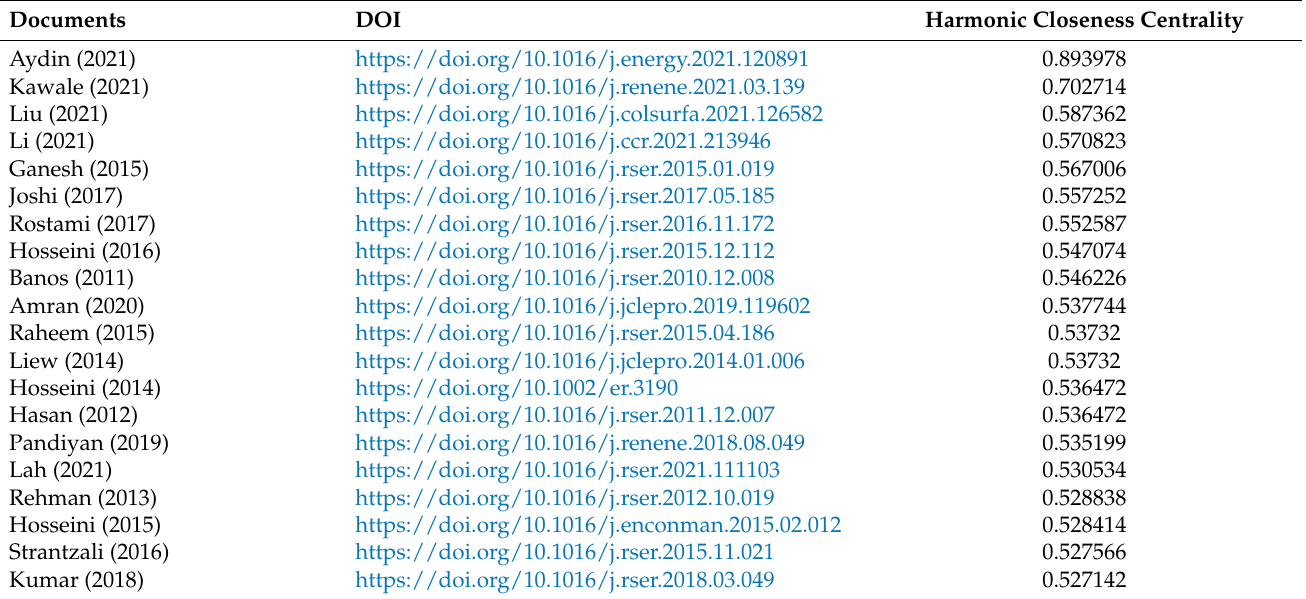
Table 6. Top-20 documents with higher harmonic closeness centrality from WoS database for biblio- graphic coupling links.